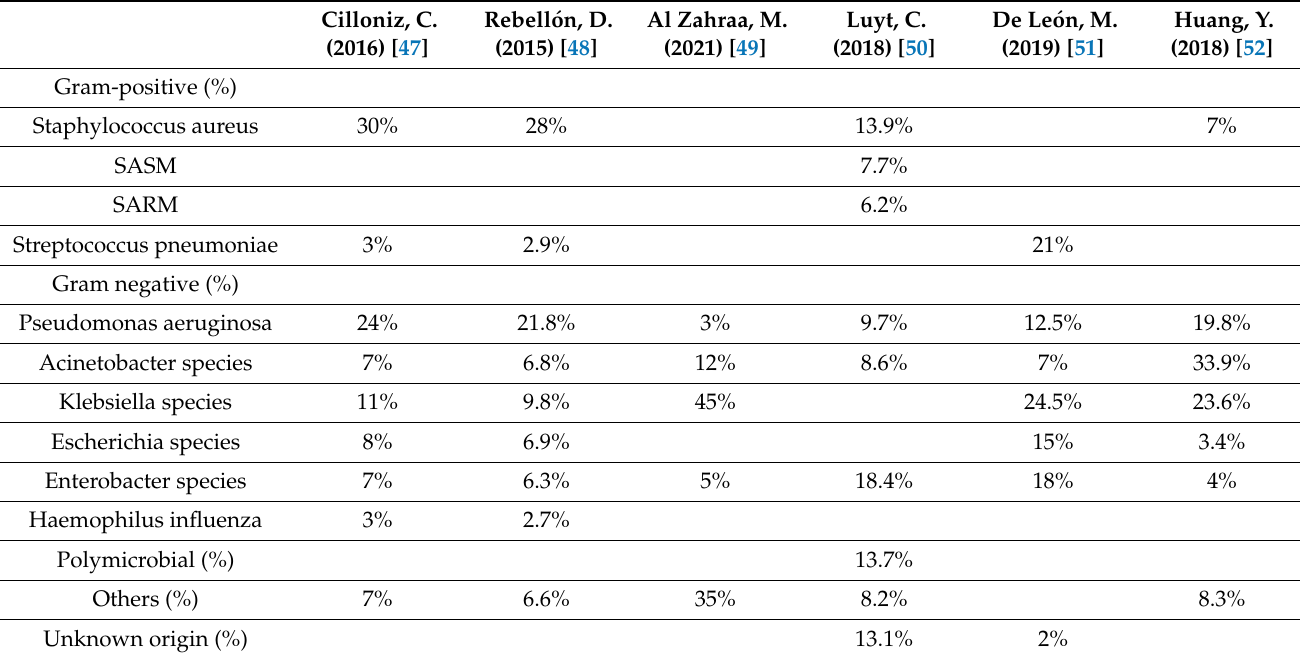
Table 2. Main results microorganisms causing VAP according to various